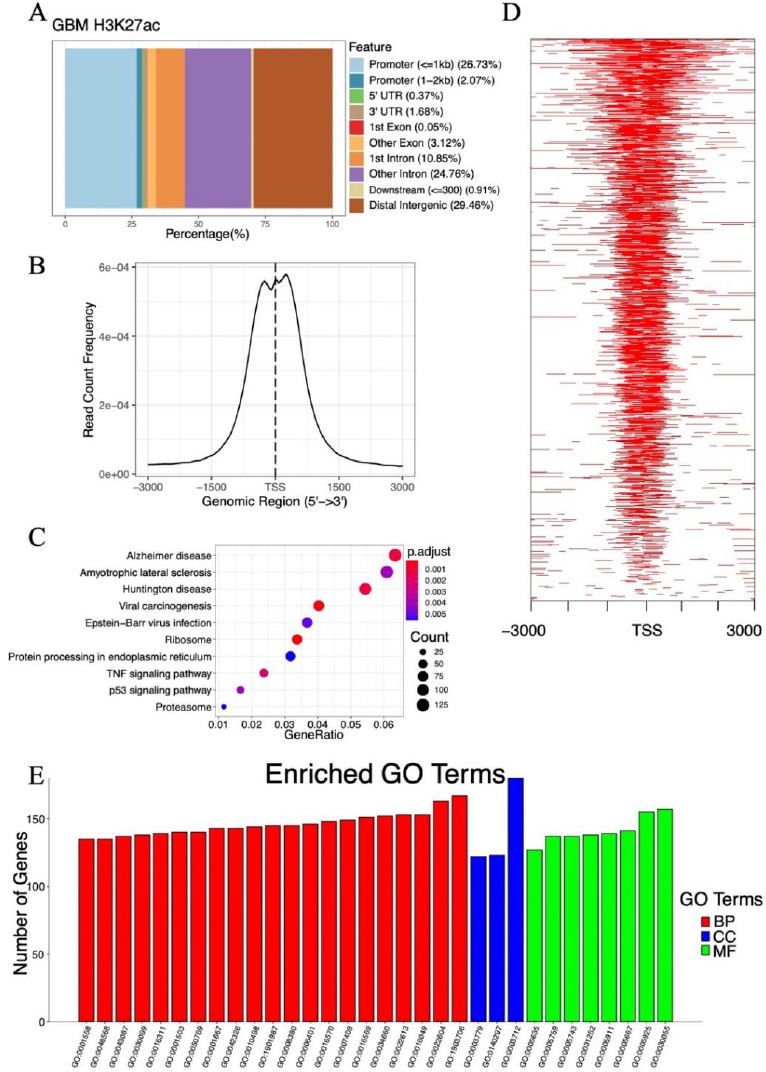
Figure 3. GSE131956 dataset analysis for the histone acetylation-controlled genes. ( A ) Distribution of peak locations including promoter, 5 (cid:48) UTR, 3 (cid:48) UTR, exon, intron, and intergenic region in the genome. ( B ) Correlation of global H3K27ac ChIP-seq peaks with TSSs. ( C ) Dot plot of top ten KEGG pathways of 5474 genes with H3K27ac peaks at their promoters. ( D ) Heatmap of the H3K27ac ChIP-seq peak at the TSS region of GBM cells. ( E ) GO analysis of 5474 genes with H3K27ac peaks at their promoters. Abbreviations: GBM, glioblastoma; UTR, untranslated region; H3K27ac, histone H3 lysine 27 acetylation; ChIP-seq, chromatin immunoprecipitation-sequencing; TSS, transcription start site; KEGG, Kyoto Encyclopedia of Genes and Genomes; GO, Gene Ontology; BP, biological process; CC, cellular component; MF, molecular function.